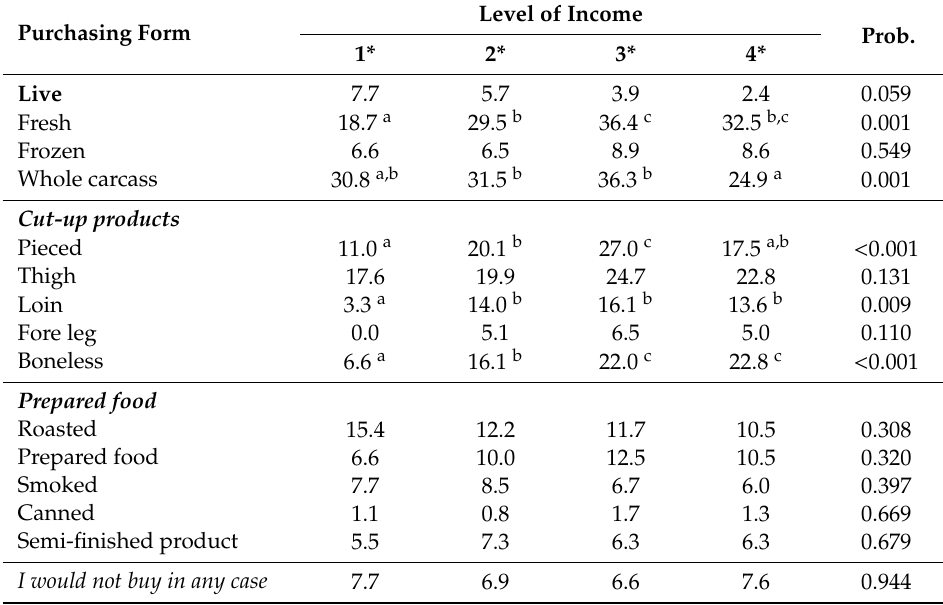
Table 4. E ff ect of purchase forms on the respondents’ attitude (%) depending on the age with multiple response